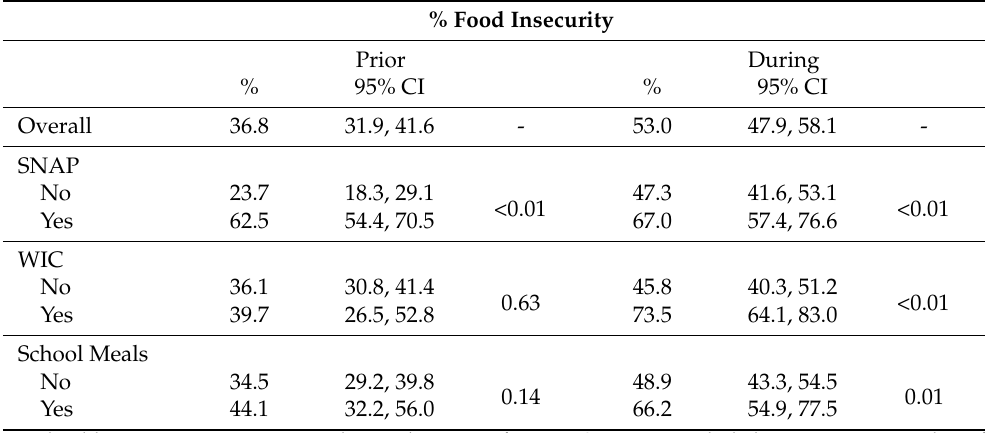
Table 2. Adjusted prevalence of food insecurity among households with children by federal food assistance program participation status prior to and during the first four months of the pandemic.